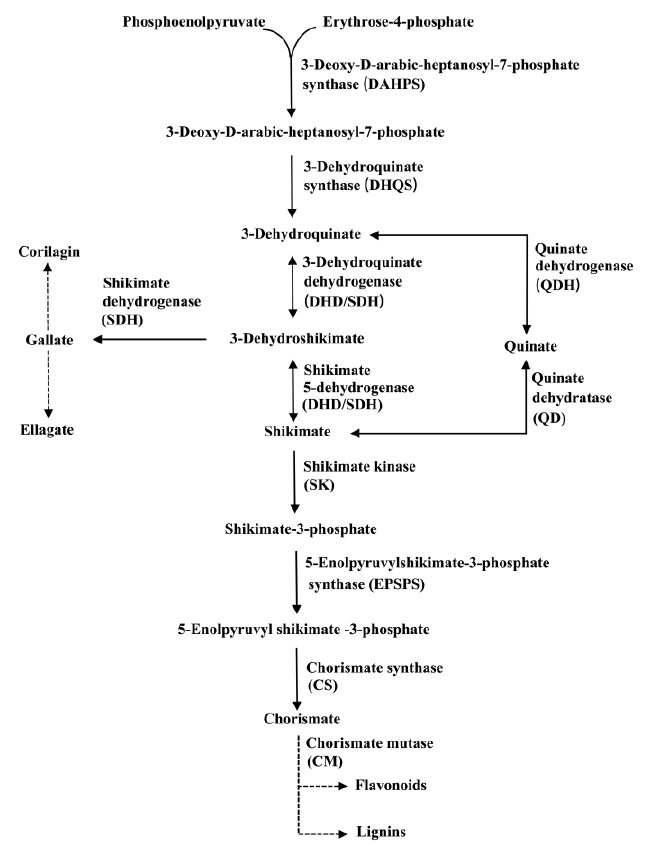
Figure 1. Shikimate pathway and aromatic acid synthesis in plants.